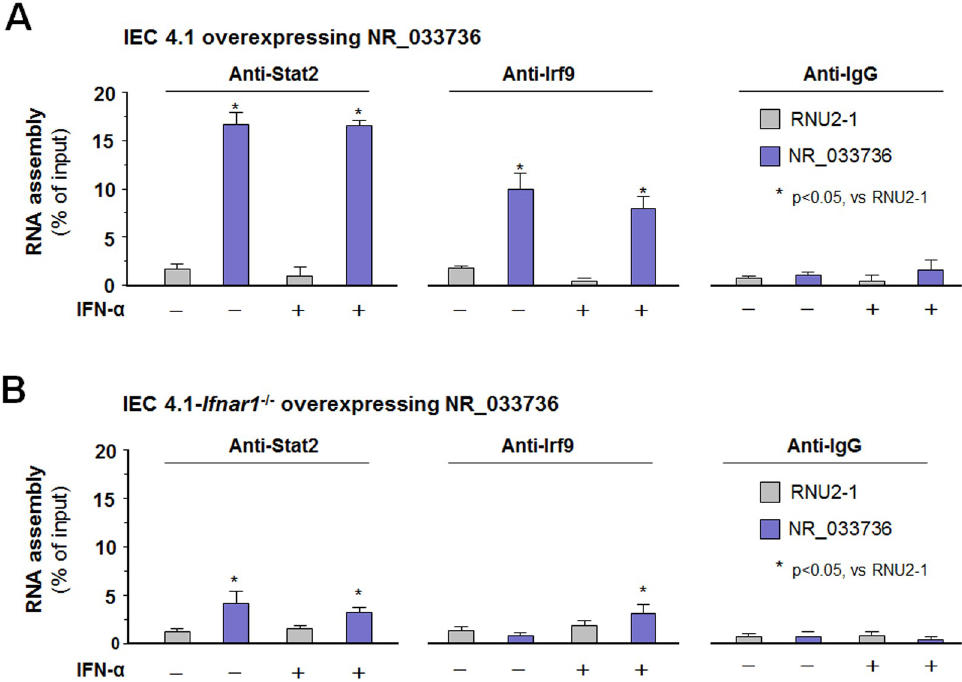
Fig 5. Assembly of NR_033736 into the ISG3 complex in intestinal epithelial cells. (A) Assembly of NR_033736 into the ISGF3 complex in IEC4.1 cells overexpressing NR_033736. Cells were transfected with the vector expression NR_033736 (Vector-NR_033736) for 24 h and cultured for additional 2 h in the presence or absence of IFN- α . RIP assay was carried out using antibodies to STAT2, IRF9, and IgG, respectively. NR_033736 was quantified by using qRT-PCR and an unrelated ncRNA (RNU2-1) was measured for control. (B) Assembly of NR_033736 into the ISGF3 complex in IEC4.1- Ifnar1 -/- cells overexpressing NR_033736. IEC4.1- Ifnar1 -/- cells were transfected with the Vector-NR_033736 or Vector-Ctrl for 24 h and cultured for additional 2 h in the presence or absence of IFN- α . RIP assay was carried out as described above. Data represent three independent experiments.